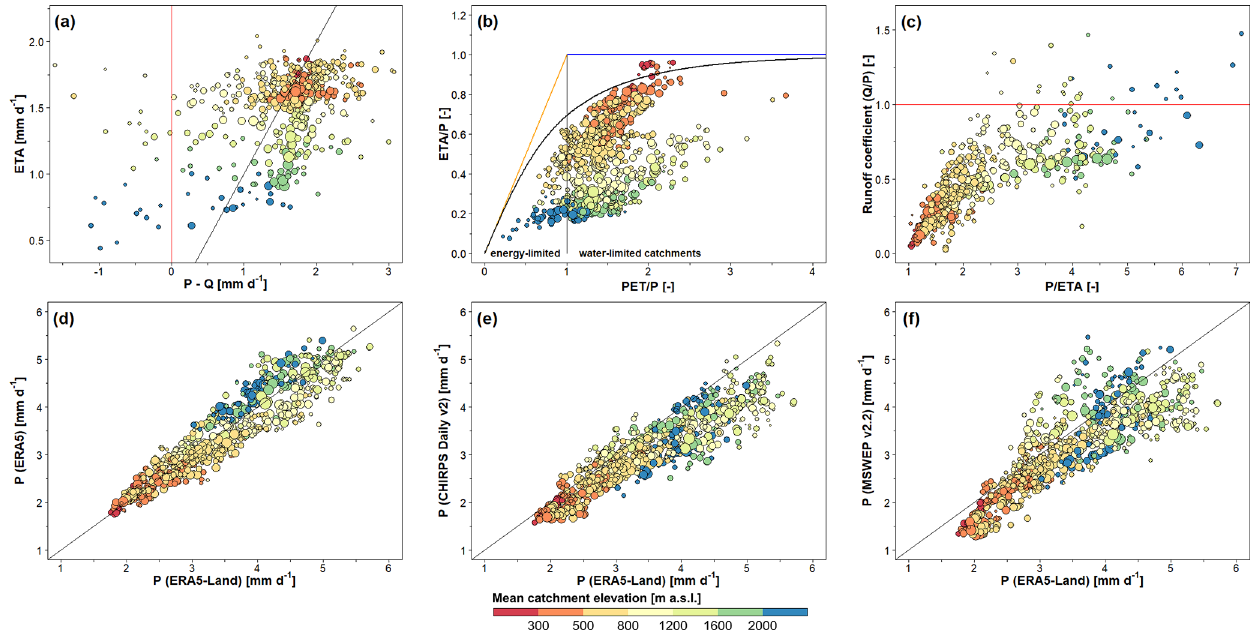
Figure 4. Analysis regarding the long-term water balance, evapotranspiration and comparison of the ERA5-Land’s mean precipitation with other datasets for the hydrological years 1990–2009 and basin delineation A. (a) Total evapotranspiration (ETA) from ERA5-Land as a function of the difference between precipitation ( P ) from ERA5-Land and recorded runoff depth ( Q ). (b) Budyko curve indicates if ETA of a catchment is limited by energy (PET /P < 1) or by water (PET /P > 1). Panel (c) shows the runoff coefficient (ratio of Q and P ) as a function of the fraction of ERA5-Land’s precipitation and total evapotranspiration. In (a–c) , values are only plotted for basins with observations for the period 1 October 1989 to 30 September 2009 (717 basins). Further, in (a, c) , values are only plotted for basins not affected by artificial water input or withdrawal, karstic springs, or high infiltration (594 basins; Sect. 5.8). Plots ( d , e and f ) illustrate the relationship between ERA5-Land’s precipitation compared to the datasets ERA5, CHIRPS Daily v2.0 and MSWEP v2.2 in 859 catchments. The diagonal black line in (a, d, e, f) is the 1 : 1 line. The red lines in (a, c) show physical constraints. The sloped orange line in (b) indicates the energy limit, while the horizontal blue line represents the water limit. The curved black line in (b) represents the Budyko curve. The size of the symbols in all plots is proportional to the catchment area, while the color indicates the mean elevation of the catchment (see legend at